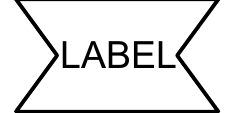
Figure 2.16: The Process Description glyph for perturbing agent .